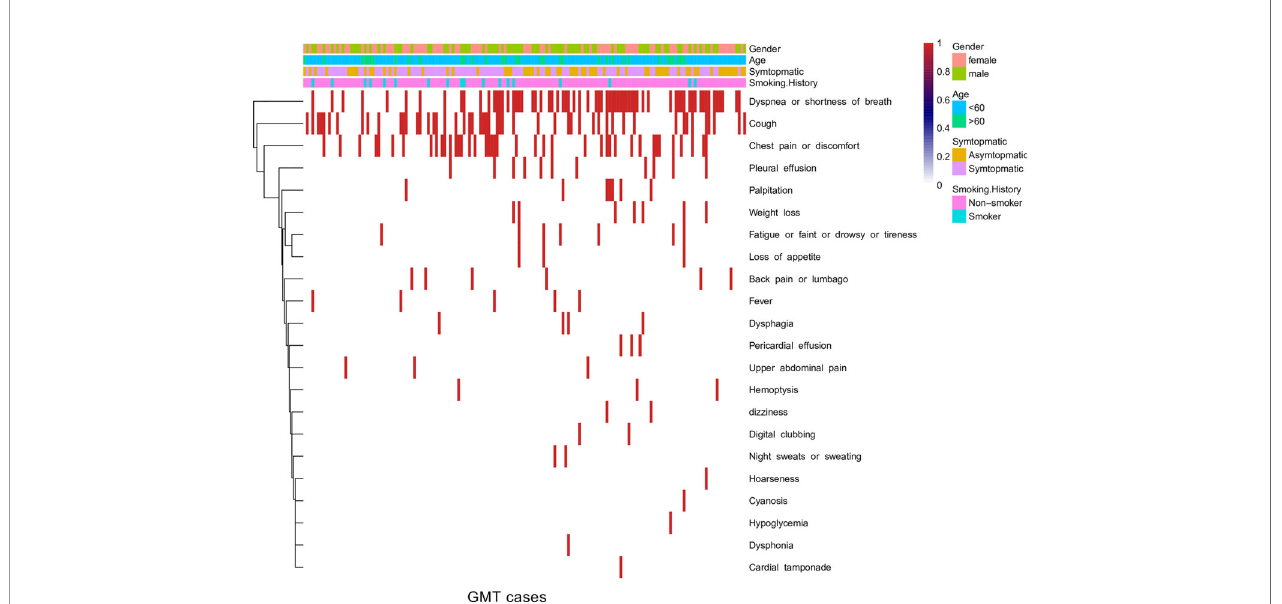
FIGURE 2 | Heatmap of GMT symptoms in the Nanfang and literature